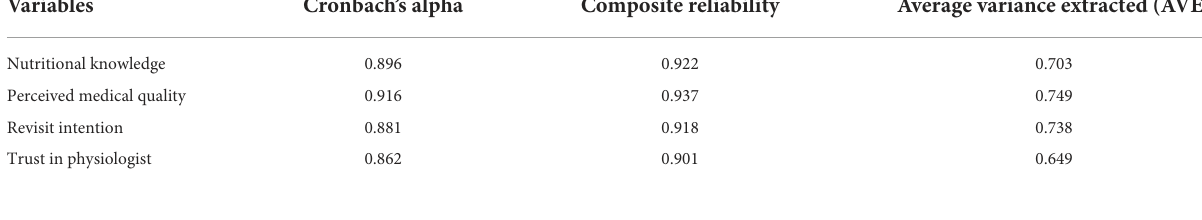
TABLE 1 Construct validity and